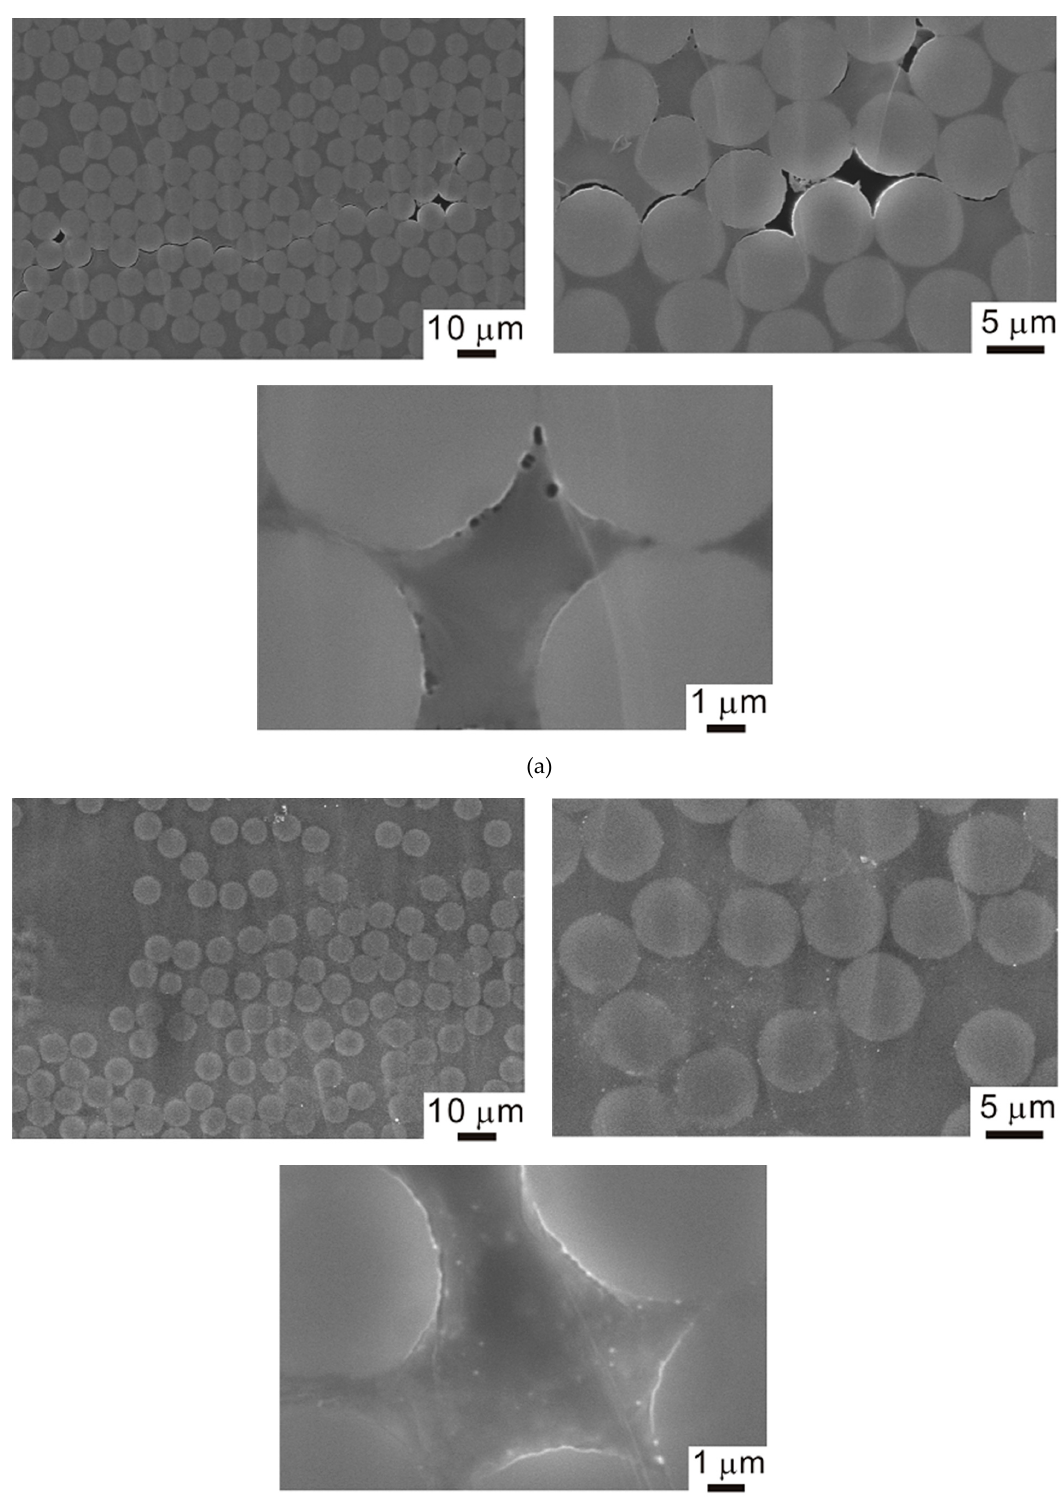
Figure 16. SEM image of CF-CFRTP and CNF-CFRTP molded by DRH-HP. ( a ) CF-CFRTP. ( b )